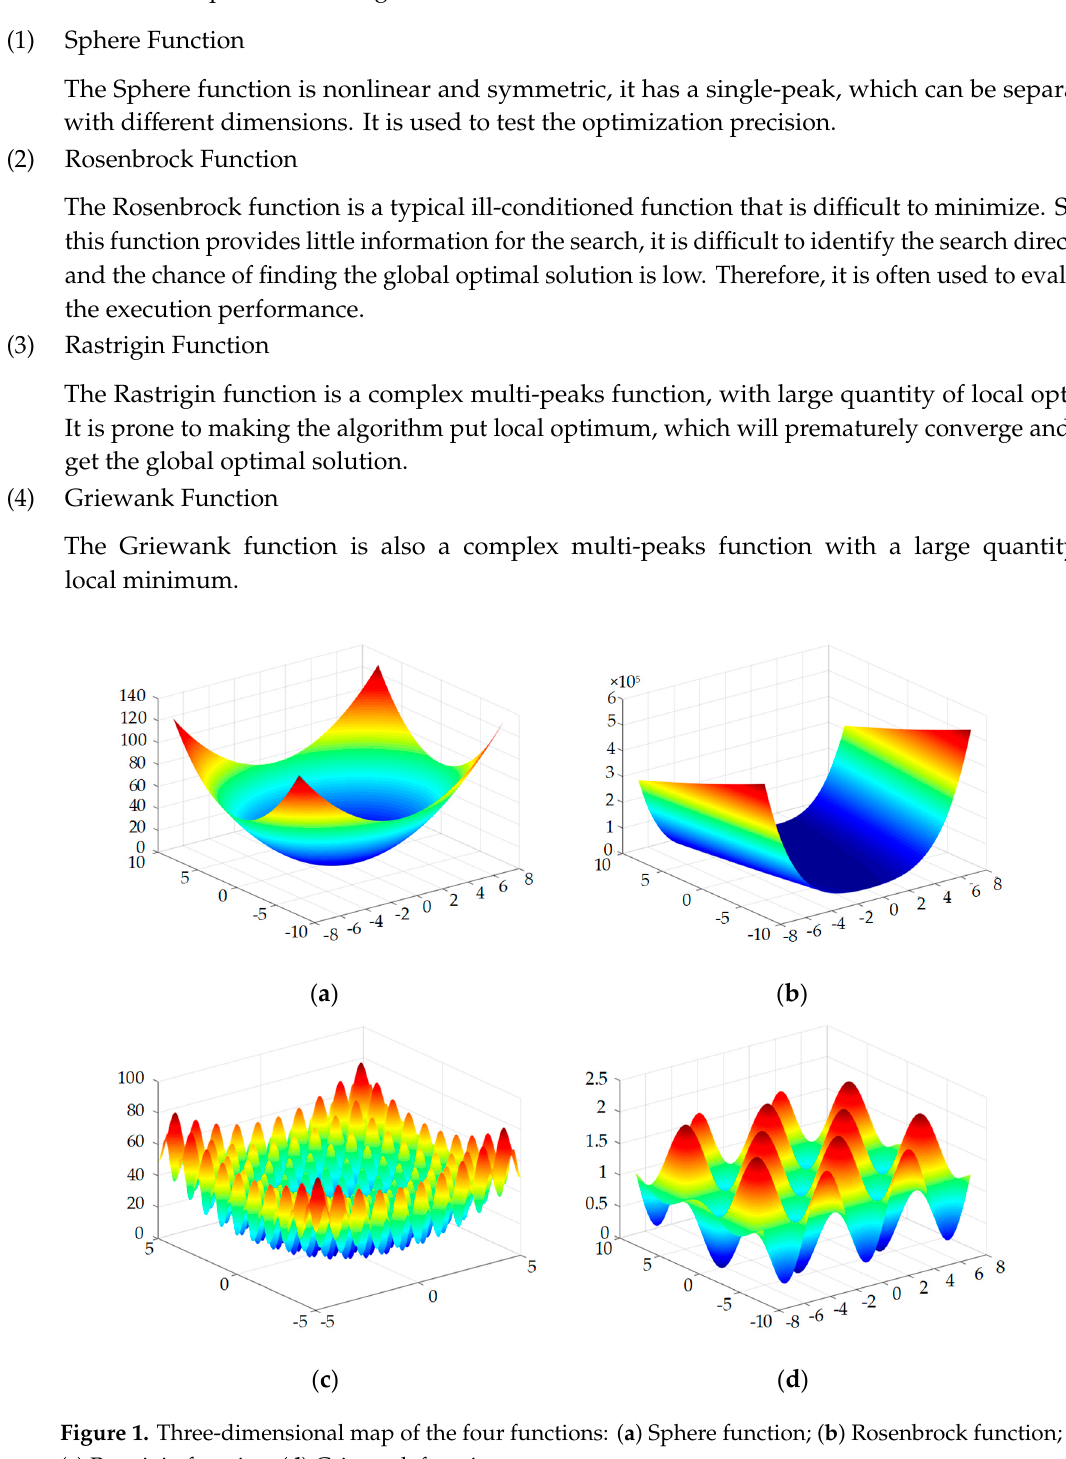
Table 1. Related information of four functions. Function Table 2. Convergence accuracy of GSAPSO, LDWPSO, WPSO algorithms. Functions